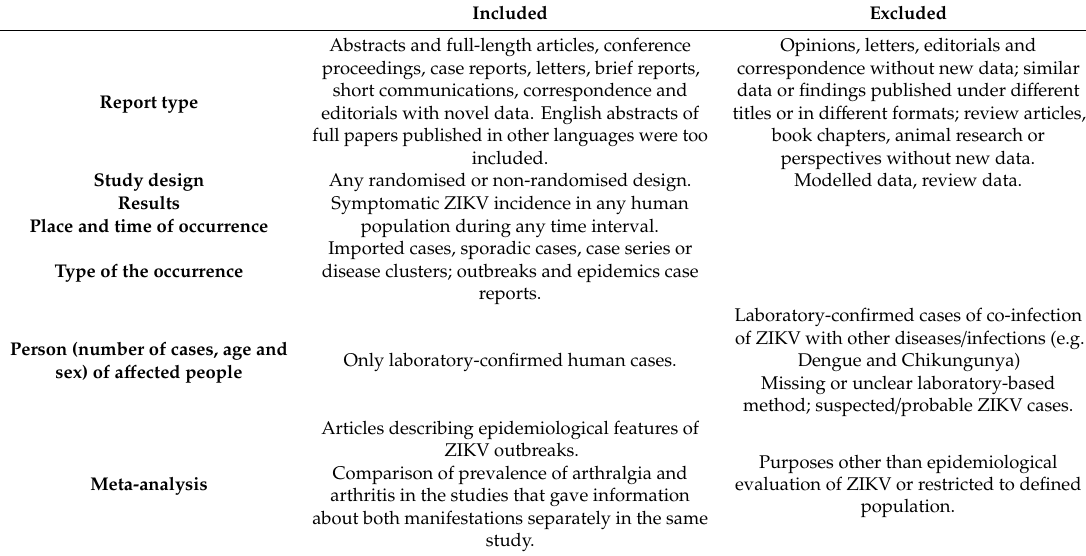
Table 1. Criteria for inclusion or exclusion of records for this systematic review. Included